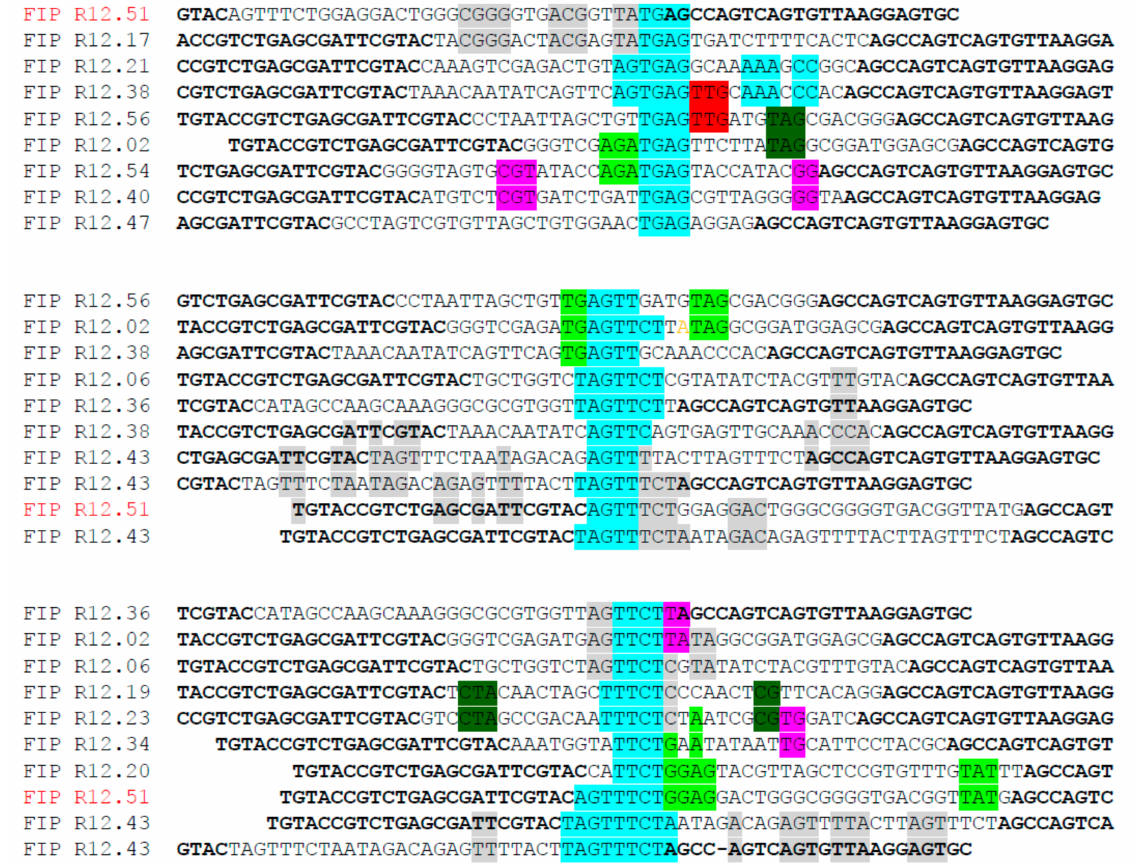
Figure 2. Representative sequence families of the round 12 library. Partial constant regions are shown in bold letters. The variable regions are shown in regular letters. R12.51 candidate MRE represented in multiple sequence families, and shared similarity with other sequences in their corresponding families. The turquoise color indicates the center for alignment in each family and other colors represent sequence similarity of each